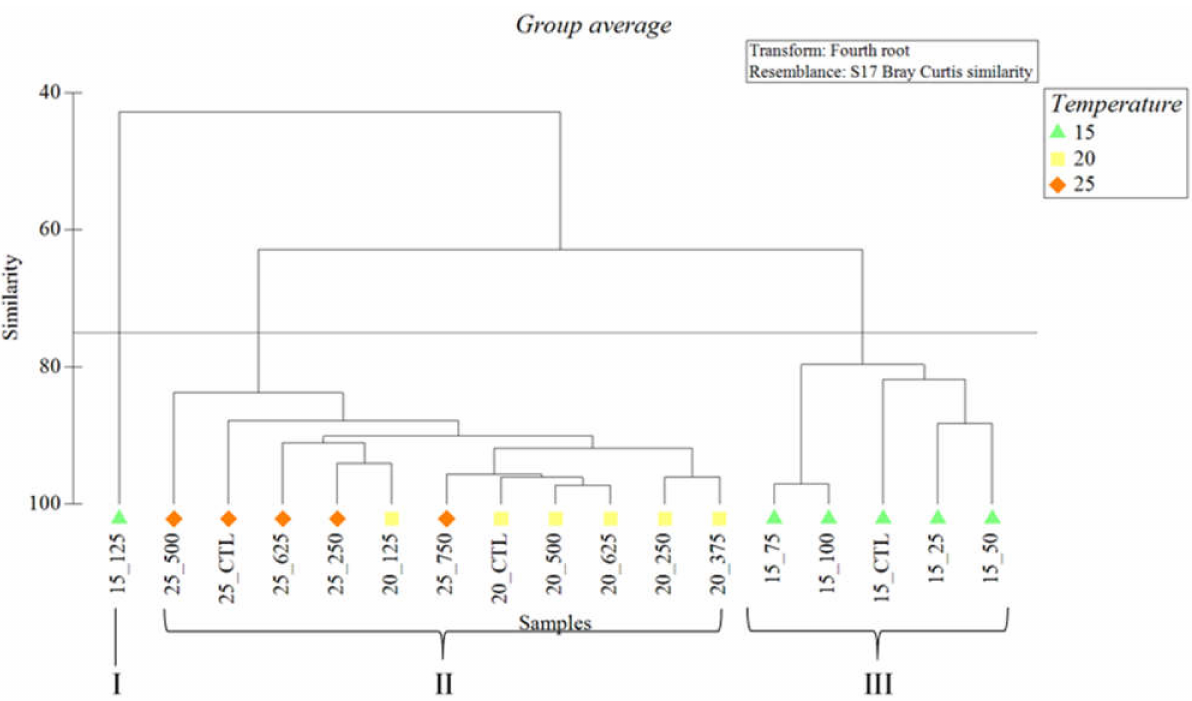
Figure 5. Cladogram (cluster analysis) grouping the diatoms related with FA content after the exposure to copper sulfate at 15 ◦ C, 20 ◦ C, and 25 ◦ C.